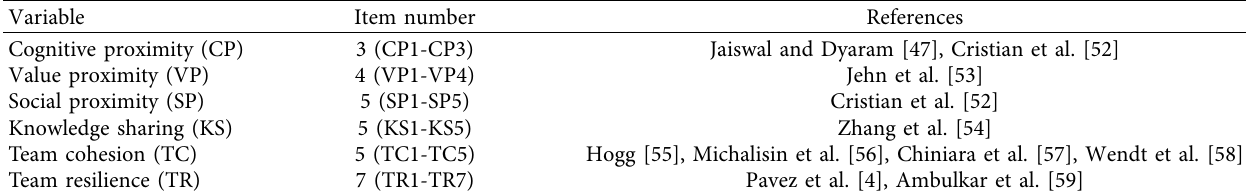
Table 2: Variables and their